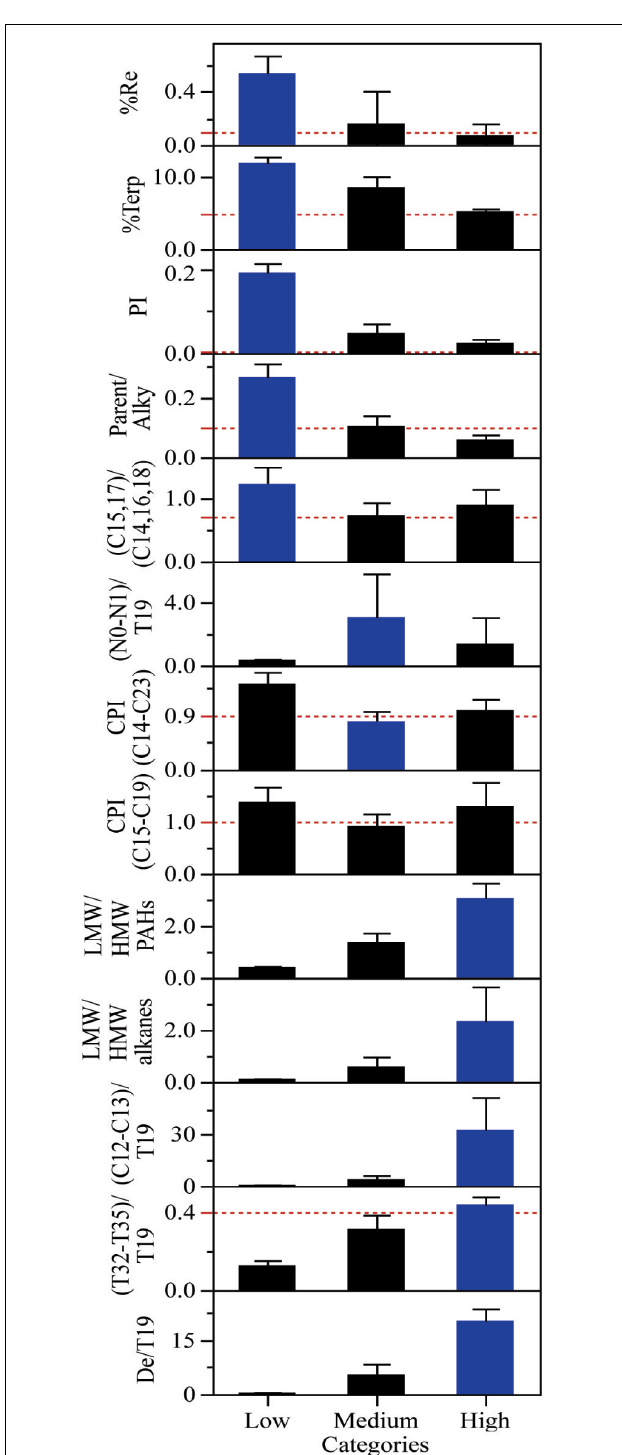
FIGURE 4 | Diagnostic ratios by categories of %LMW compounds (low, medium, and high) in contaminated sediments collected in 2010–2011 in the nGoM (surface sediment layer). DWH oil standard (NIST 2779) is shown as a dash line if values are within the range observed for the samples. Blue bars indicate values statistically different at P < 0.001. Data shown as mean ± 95% confidence interval.